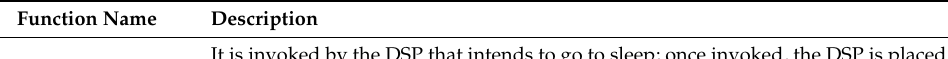
Table 3. Core activation and deactivation functions.